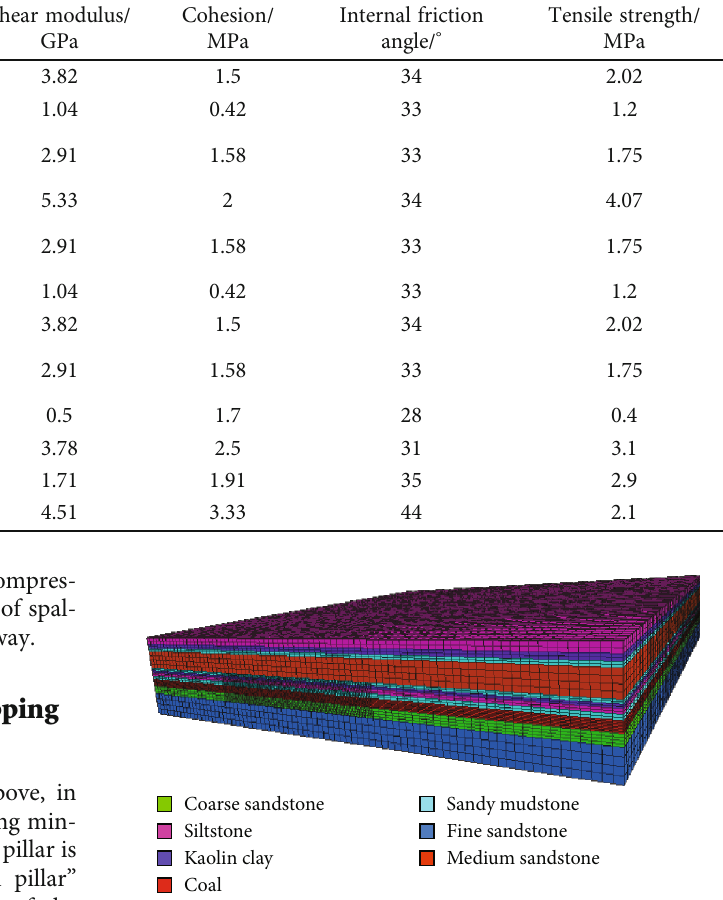
Figure 10: Three-dimensional model of numerical